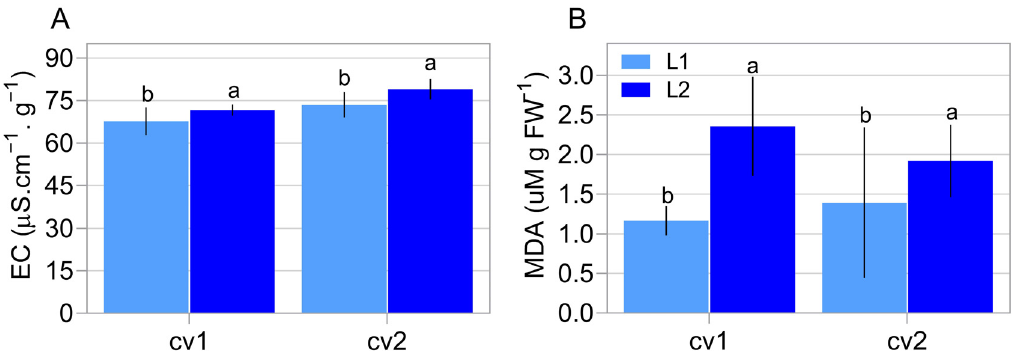
Figure 3. Biochemical properties in two commercial cultivars (cv1-BRS133 and cv2-MG/BR 46 (Conquista)) and their respective seed lots (L1: lot 1 and L2: lot 2). Electric conductivity ( A ) and Estimation of lipid peroxidation (MDA) ( B ). Distinct letters indicate a significant difference at the 5% probability level ( p < 0.05). Error bars show standard deviation ( n = 8).